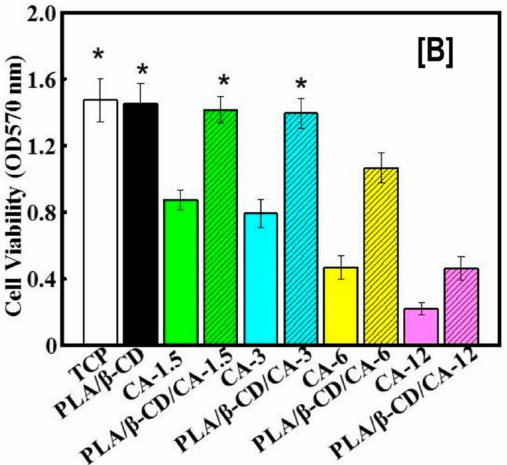
Figure 12. The effects of poly(lactic acid) nanofibers containing β -CD/cinnamaldehyde (CA) inclusion complex on the cumulative release of CA and cell viability of human skin fibroblasts. The cumulative release of CA depended on the β -CD/CA concentration, i.e., the higher the concentration, the higher the release rate of CA, possibly owing to improved dissolution of CA from β -CD complex ( A ). In comparison, low cell densities of S. aureus and E. coli were observed with increasing β -CD/CA complex concentrations. Similar trends were also seen with the proliferation of human skin fibroblasts cells, when exposed to CA containing PLA nanofibers or free CA ( B ). Images adapted and reproduced with permission from [111] Copyright Liu et al.,